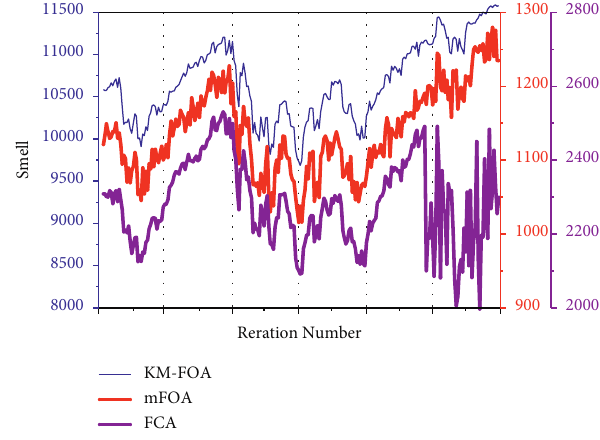
Figure 5: Convergence curve of the Benchmark function.